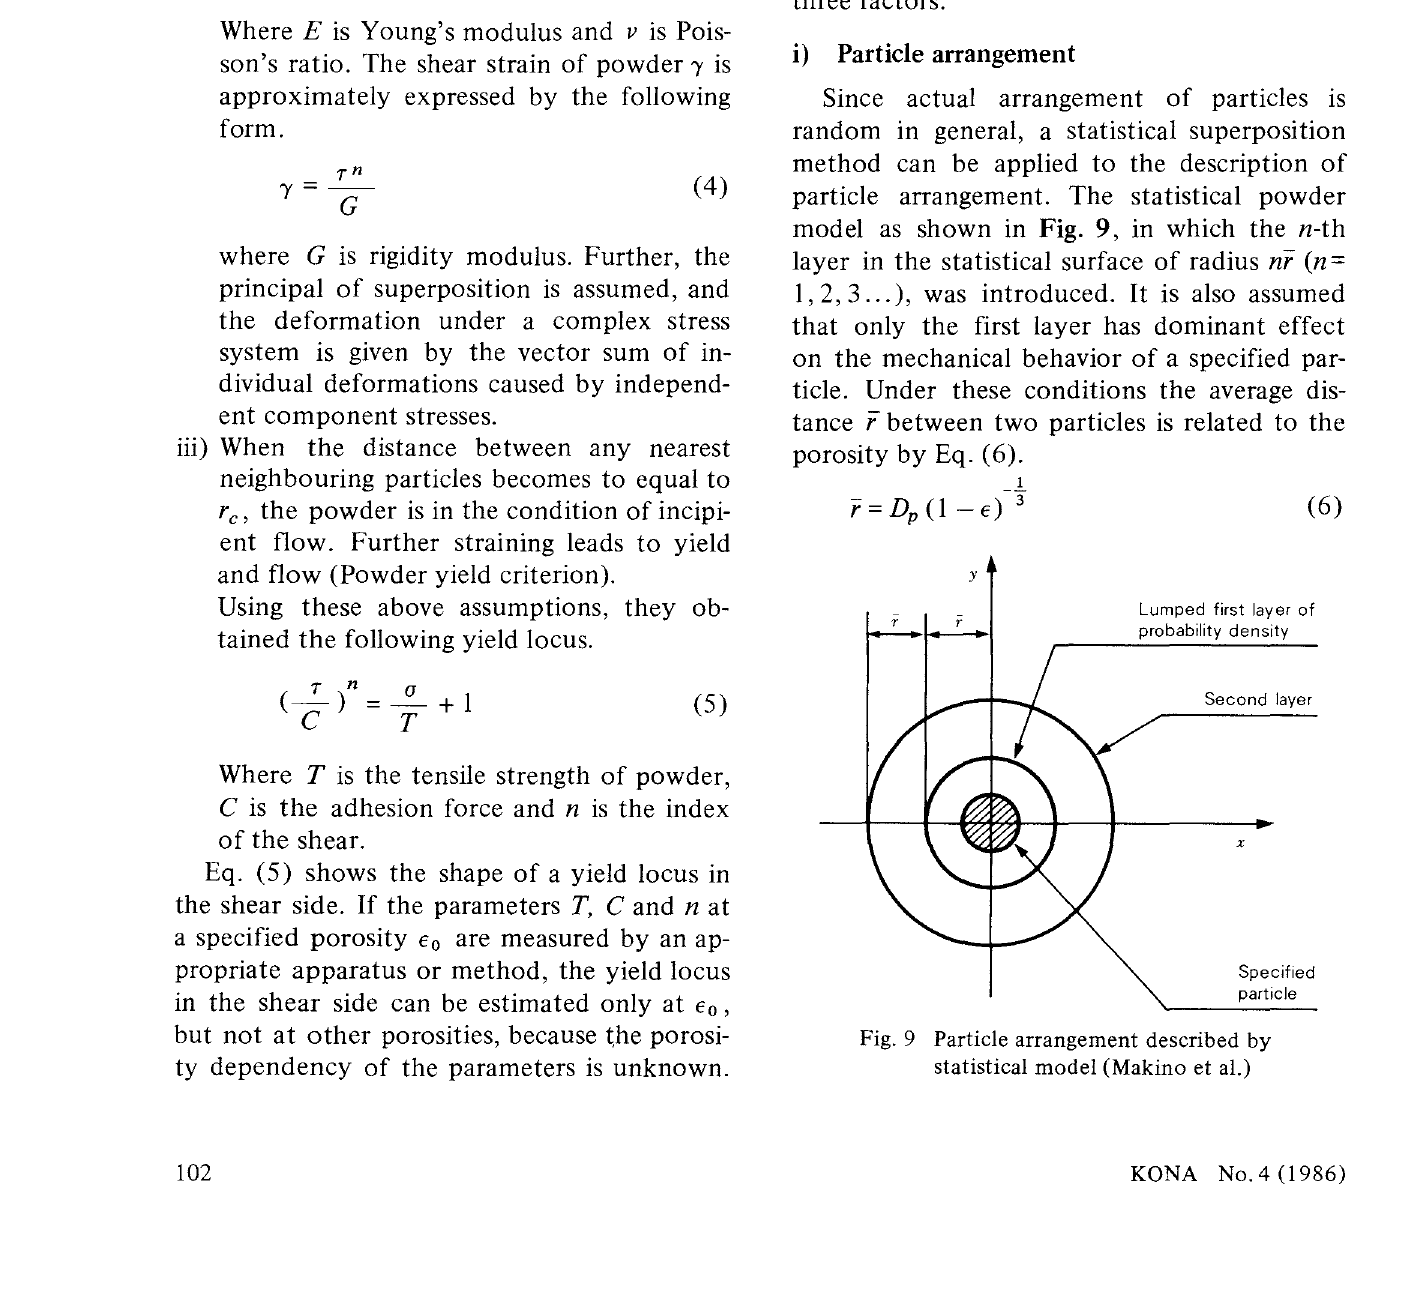
Fig. 8 Interaction function between particles in powder (Ashton et al.)